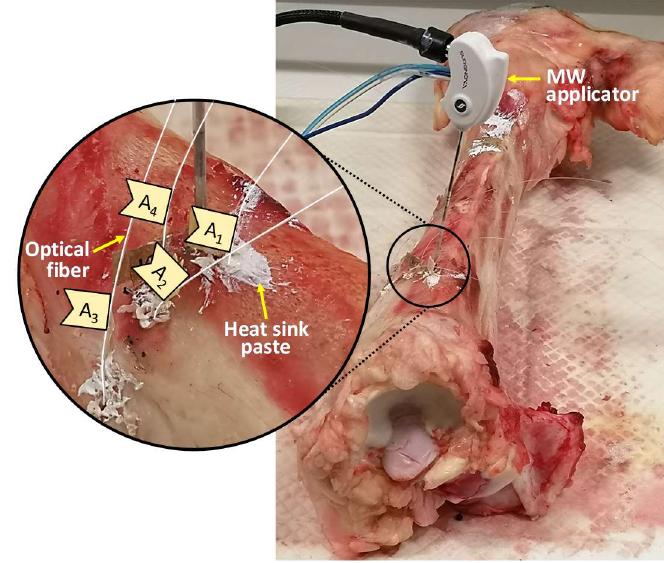
Figure 1. Photo of the experimental setup used during the ablation of the bovine tibia; for the sake of clarity, the insertion site of microwave (MW) applicator and optical fibers is zoomed in on.